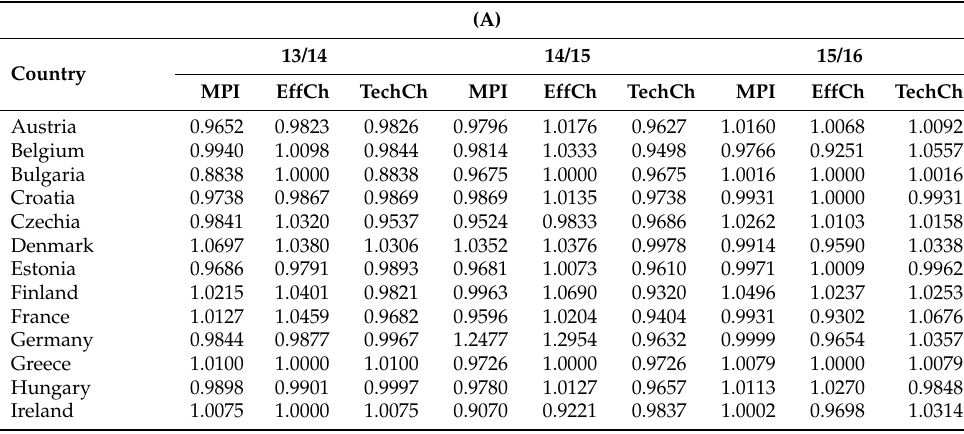
Table 4. ( A ) Results of Malmquist productivity measurement with regard to the previous period. ( B ) Results of Malmquist productivity measurement with regard to the previous period.